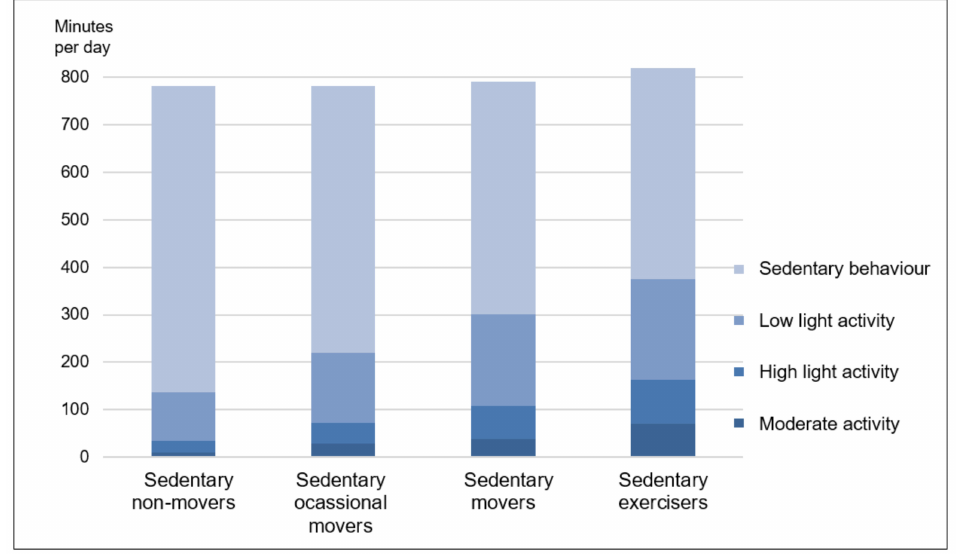
Figure 2. Daily time of the four clusters in sedentary time and in activities of low light, high light and moderate